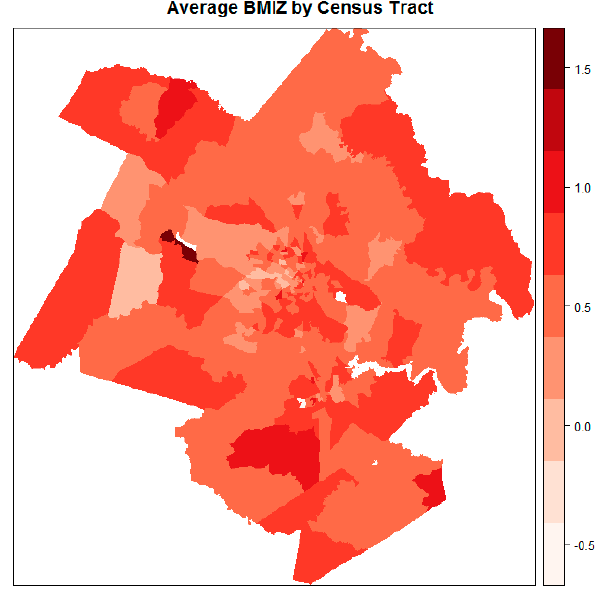
Figure 1. Average body mass index (BMI) z-score (BMIZ) by census tract among study patients in the Richmond metropolitan statistical area.